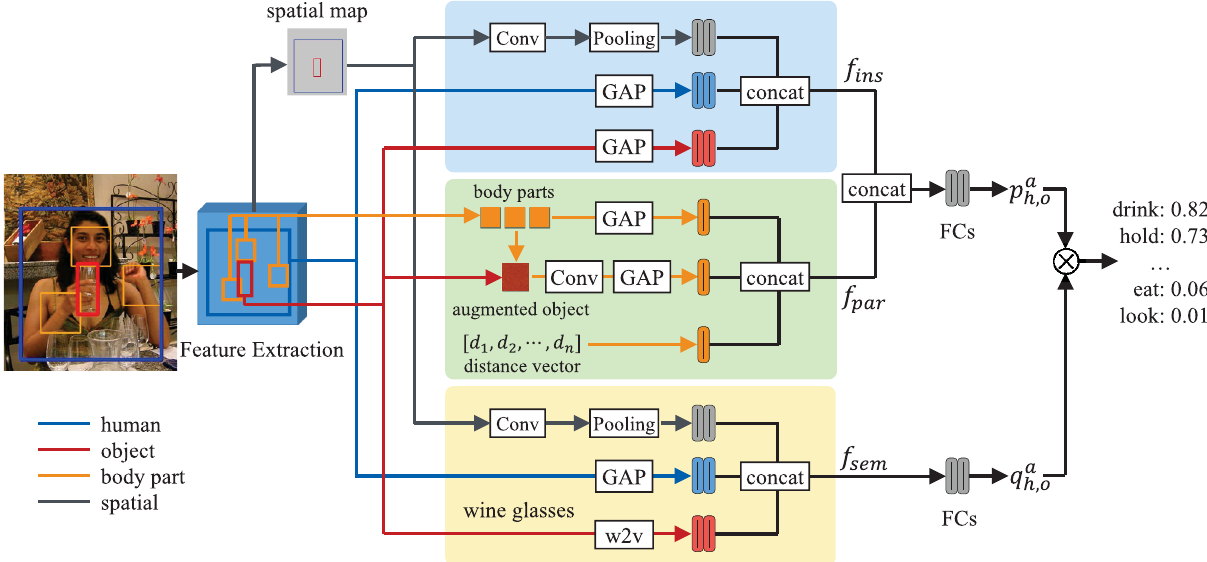
Fig. 2 Architecture of our pairwise feature network. Human boxes, object boxes, and body part boxes extracted from the input image are fed to three streams to learn instance-level, part-level, and semantic-level pairwise features, respectively, using both visual and spatial information. The final action prediction is obtained by score